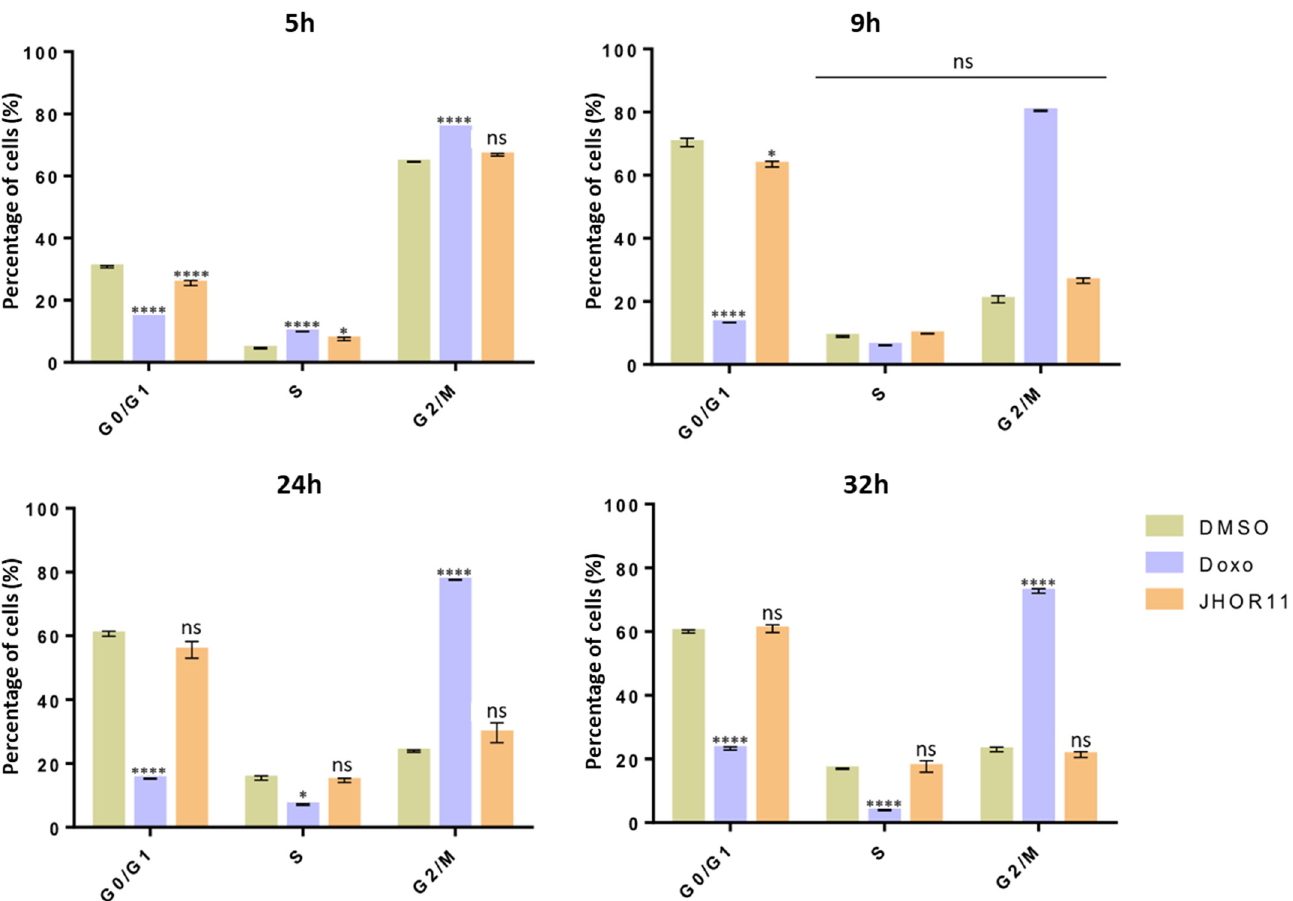
Figure 9. Analysis of the cell cycle for 5 h, 9 h, 24 h or 32 h of A2780 cells after exposure to IC 50 of complex JHOR11, 0.1% ( v / v ) DMSO as vehicle control or 0.1 µ M doxorubicin (Doxo) as positive control. Bars represent the average ± SD of at least three independent experiments. * p value < 0.05, **** p value < 0.001, n.s.—not significant relative to respective vehicle control